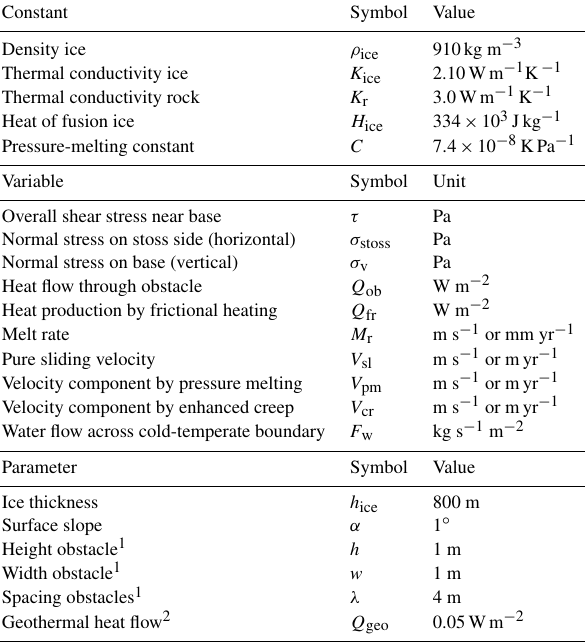
Table 1. Constants, variables and parameters with chosen